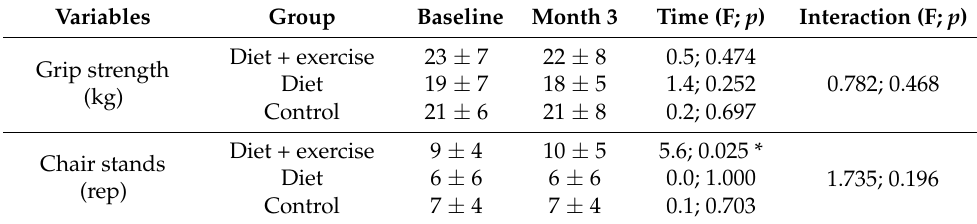
Table 3. Upper and lower body strength measures per assessment, per